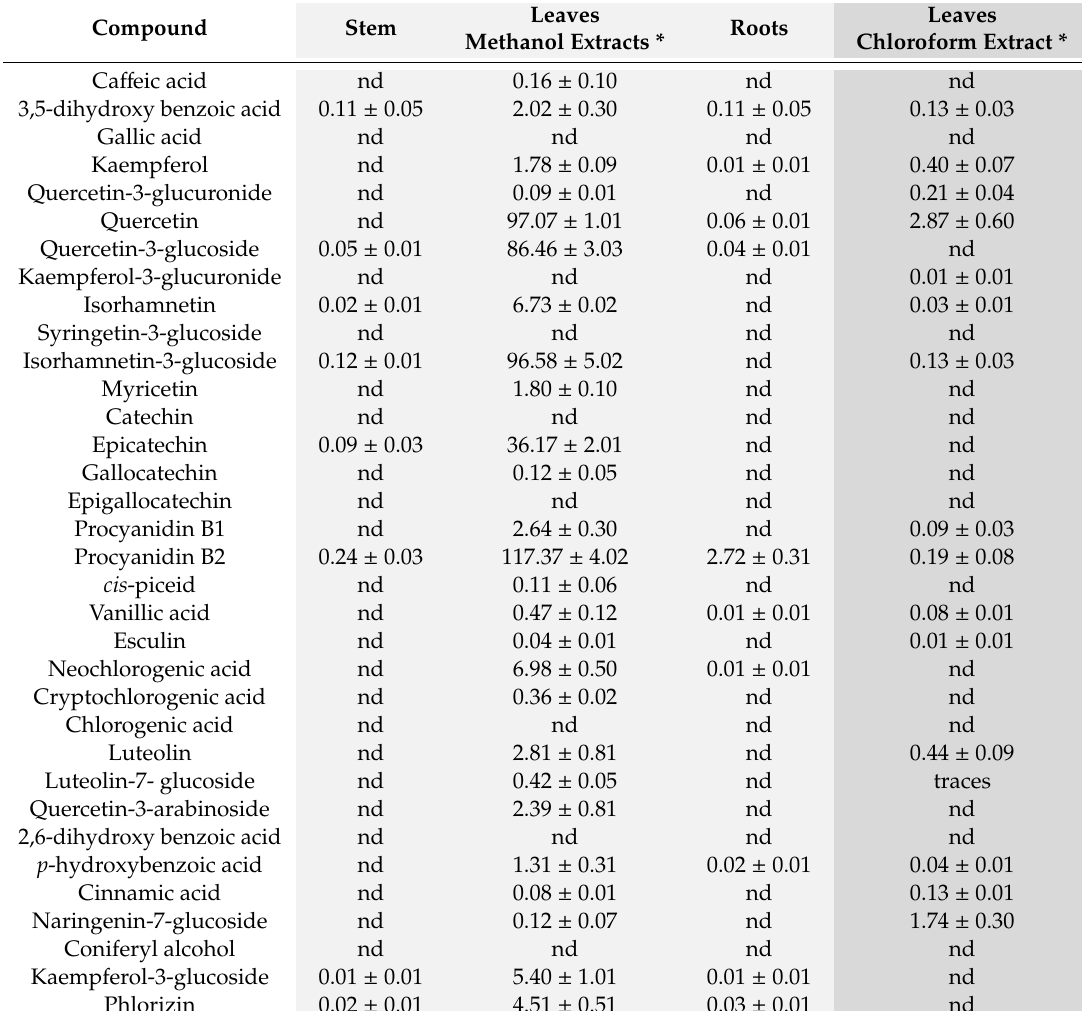
Table 1. Phenolic profile of extracts from Hypericum mexicanum